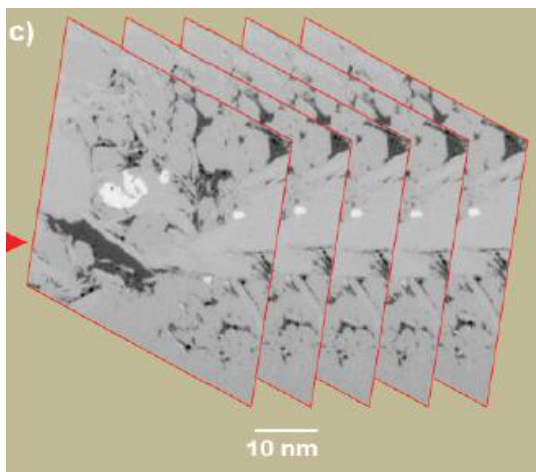
Figure 1—Cross-sectional slices by FIB-SEM.